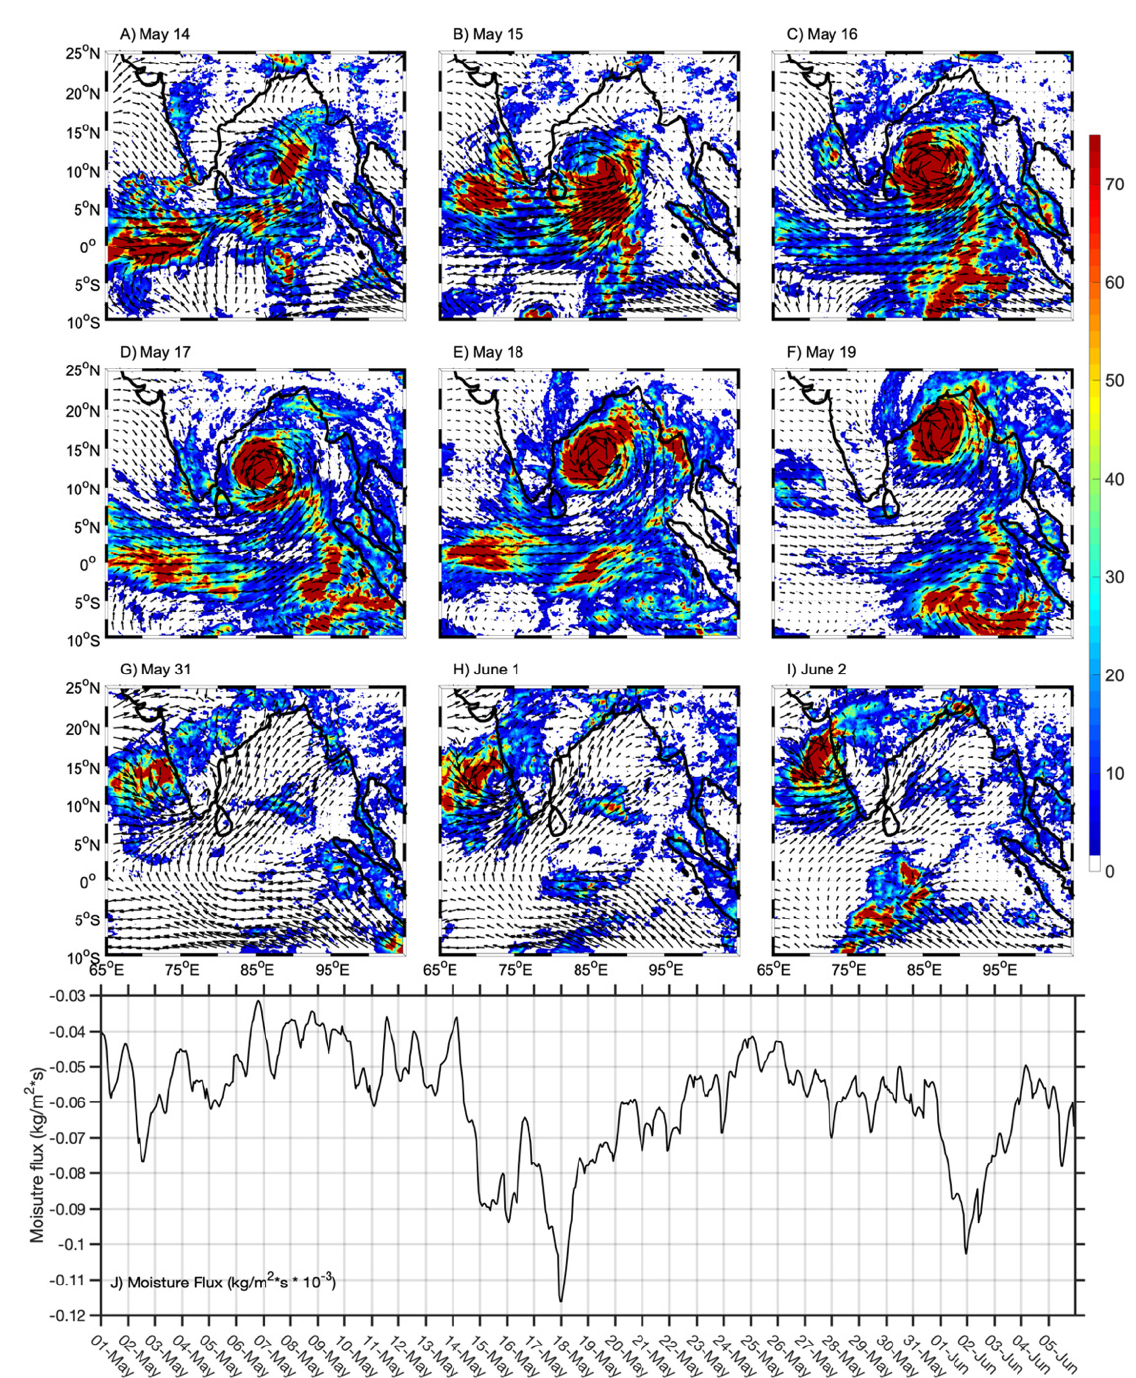
Figure 12. Spatial plots of GPM precipitation rate (shaded; mm / day) for: ( A ) May 14, ( B ) May 15, ( C ) May 16, ( D ) May 17, ( E ) May 18, ( F ) May 19, ( G ) May 31, ( H ) June 1, and ( I ) June 2, with ( J ) a box-averaged time series of ERA5 instantaneous moisture flux data (kg / m 2 *s*10 − 3 ) in the southeastern Arabian Sea (65–70 ◦ E, 6–13 ◦ N) from May 1 to June 5, 2020.